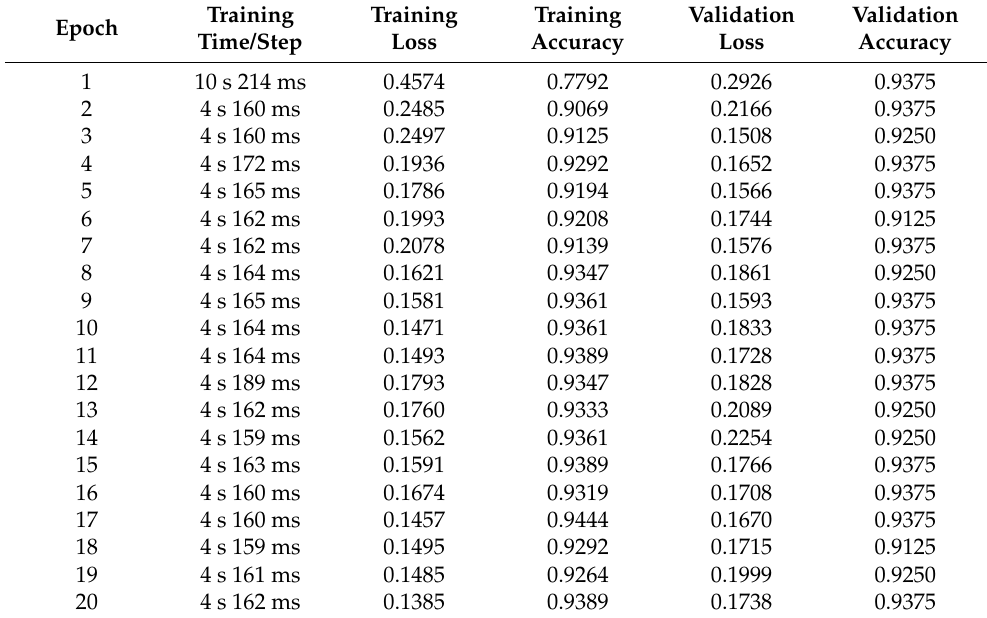
Table 7. The performance effects of the number of epochs on the BiGR model.